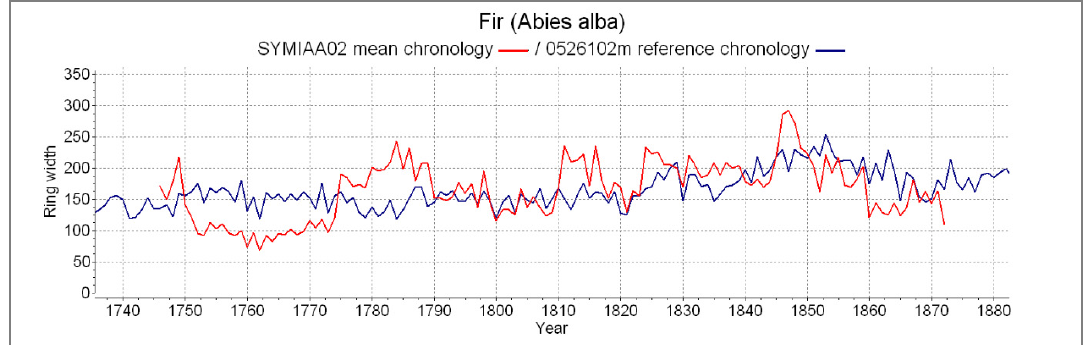
Figure 4. Visual cross-matching of the fir chronology (SYMIAA02, in red) with the revised version of the South German Abies alba chronology (0526102m, in blue) [37]. Only the overlapping period of the two chronologies is presented here.